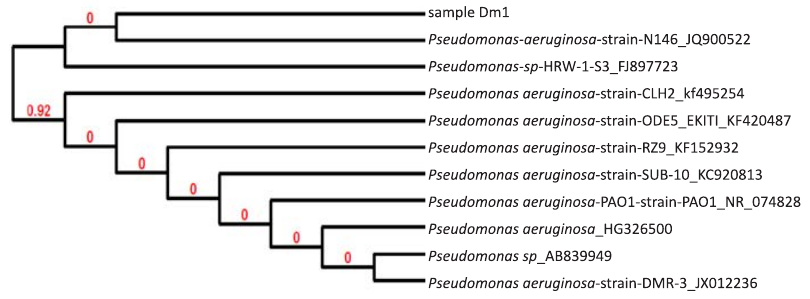
Fig. 1. Phylogenetic tree of zinc-tolerant P. aeruginosa DM1 based on partial 16S rRNA sequence